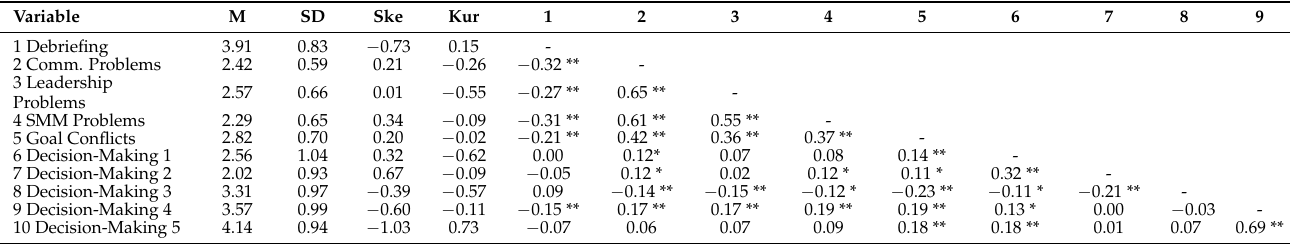
Table 1. Intercorrelations between all study